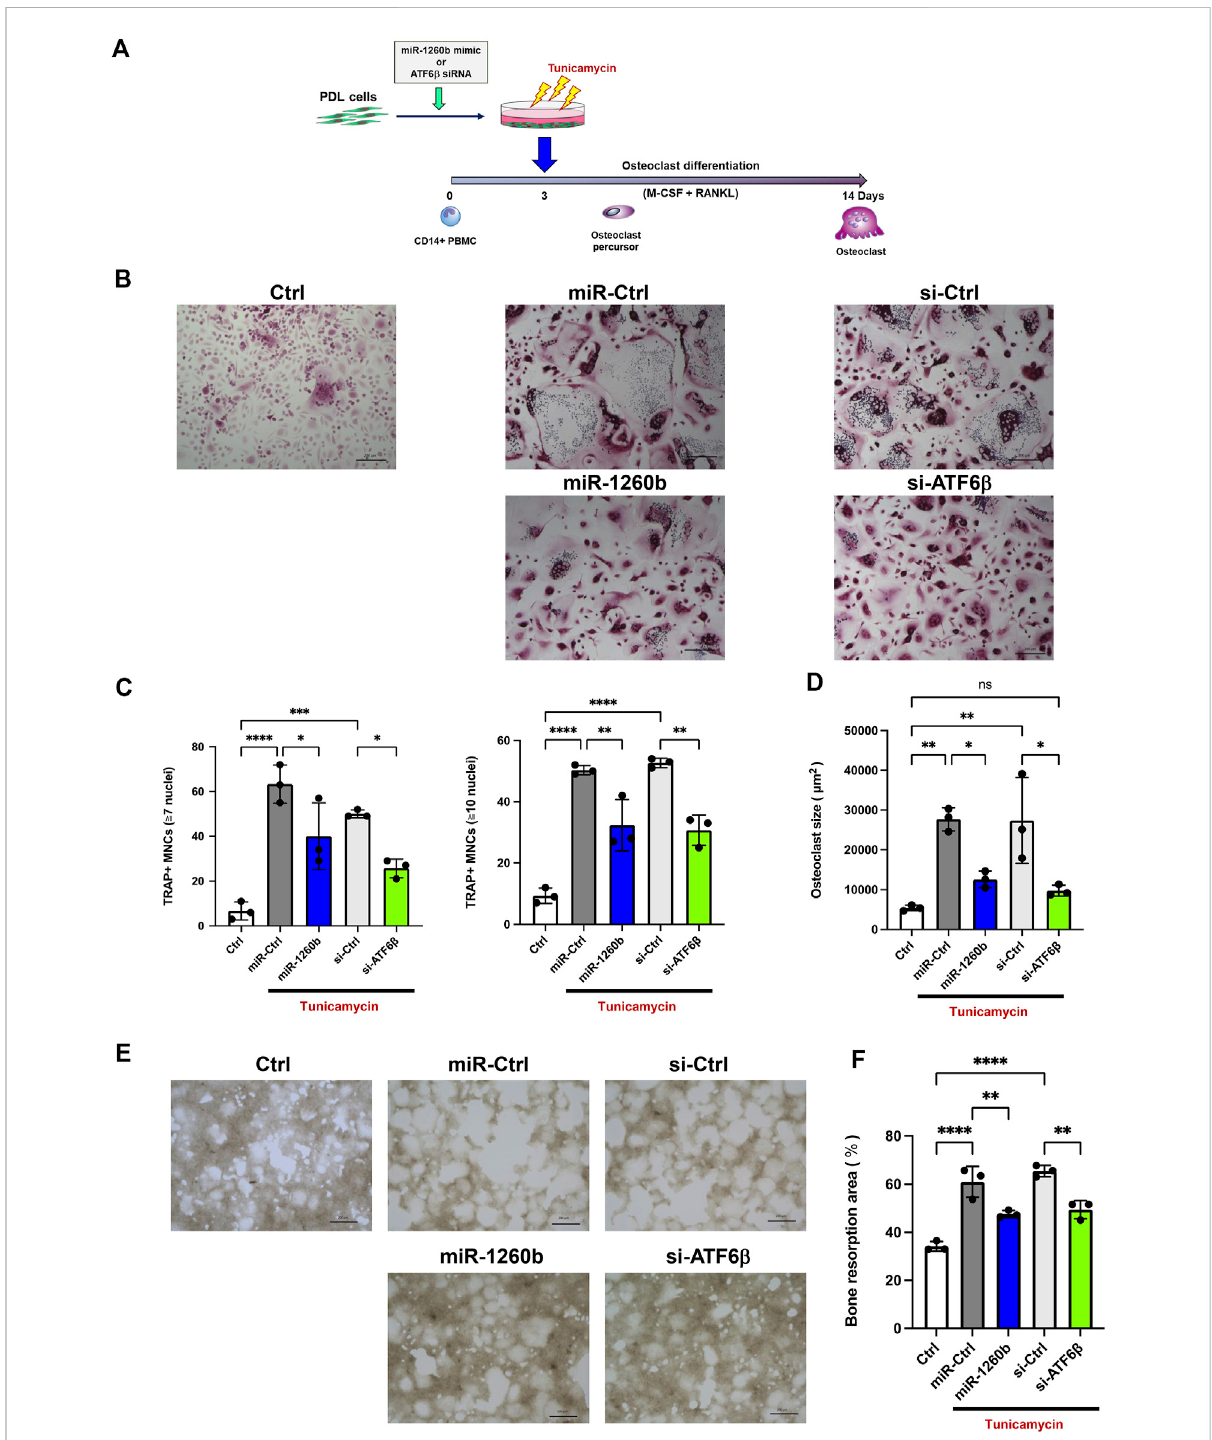
Cell culture supernatant from miR-1260b mimic/ATF6 β small interfering RNA (siRNA)-transfected PDL cells inhibits osteoclastogenesis in CD14 + peripheral blood-derived monocytes (PBMCs). (A) Scheme for the validation of the effect of cell culture supernatant from PDL cells on osteoclast differentiation. PDL cells were transfected with either miRNA mimic (miR-Ctrl or miR-1260b) or siRNA (si-Ctrl or si-ATF6 β ) for 24 h. After changing the medium, cells were stimulated with tunicamycin (0.5 μ g/ml) for 24 h. CD14 + PBMCs were stimulated with M-CSF for 3 days, and then incubated with the cell culture supernatant from PDL cells as described above for additional 3 days. PBMCs were further stimulated with the receptor activator of NF- κ B ligand (RANKL)/macrophage colony-stimulating factor (M-CSF) for up to 14 days (B) Representative images of